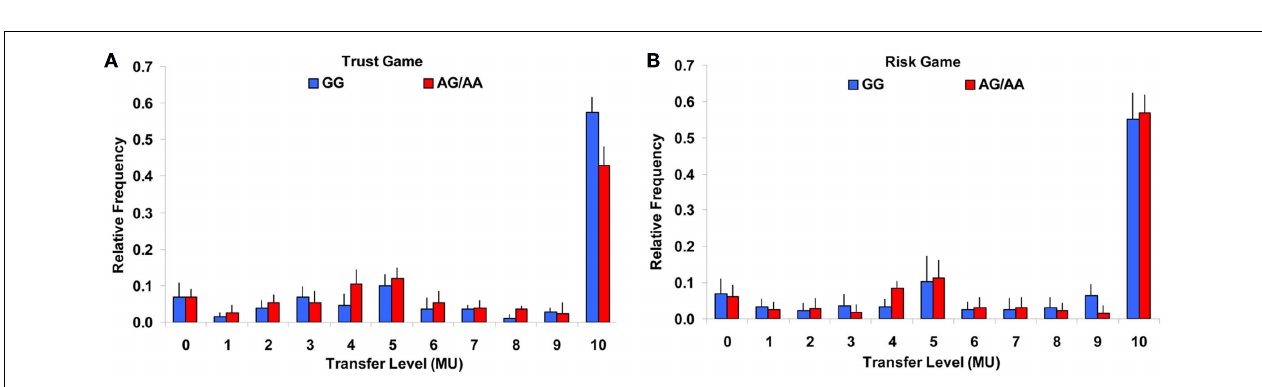
FIGURE 2 | Distribution of transfers in the trust and risk experiments. (A) Relative frequency of investor’s transfers in GG (blue bars) and AG/AA (red